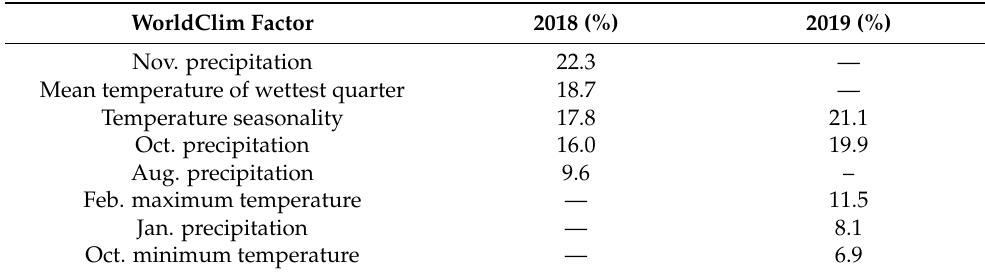
Table 2. The five variables that contributed the most to the MaxEnt ecological niche models for 2018 and